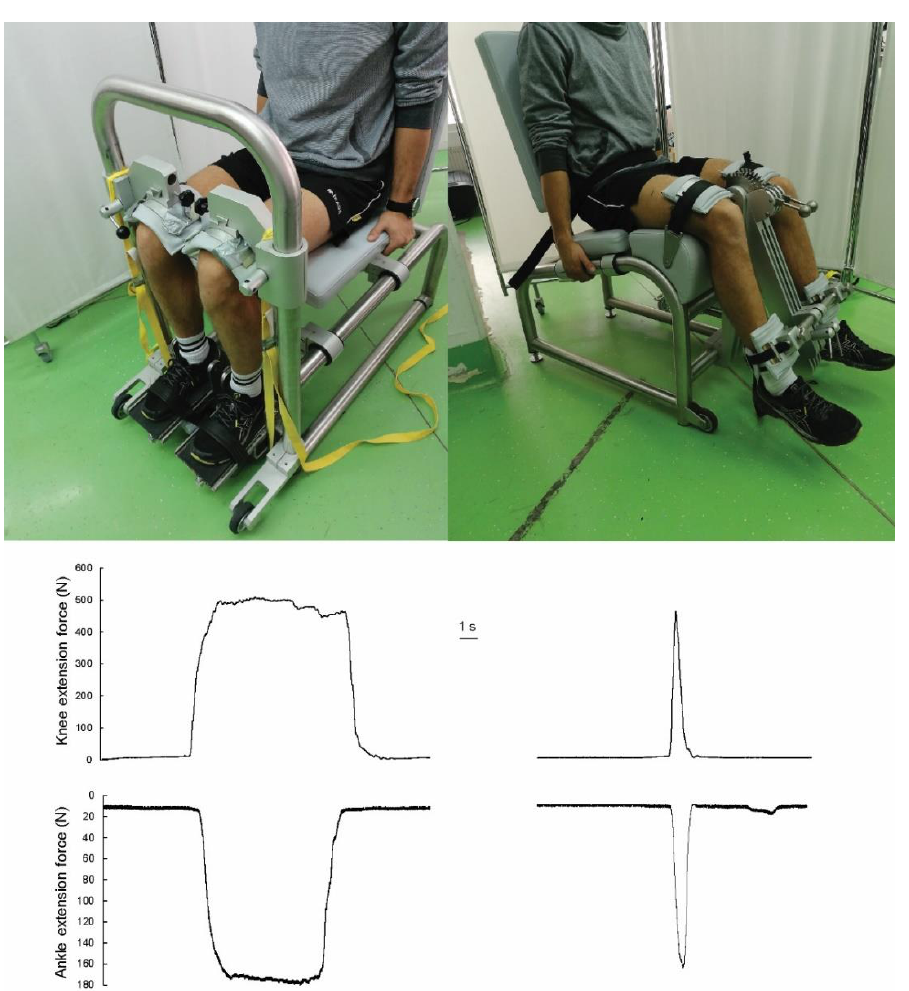
Figure 1. Dynamometers used for ankle ( top left ) and knee ( top right ) extension assessments. Examples of unfiltered signal traces for explosive sustained ( left ) and ballistic ( right ) contractions are shown on the bottom half of the figure. The webbing straps on the ankle dynamometer are routinely used because the rigid elements of the dynamometer can give out, in rare case of assessing very strong individuals (~600 N and above), which was not an issue in the current investigation.